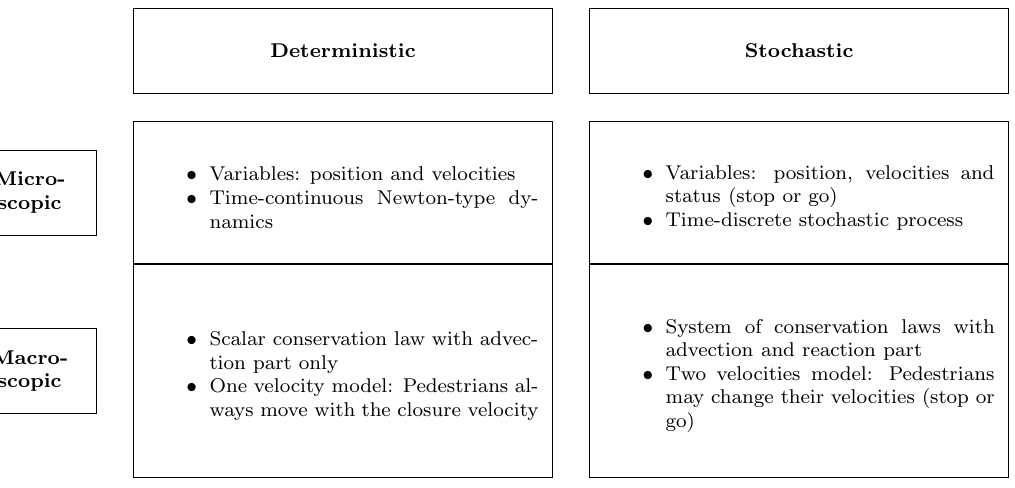
Figure 1: Overview of the deterministic and stochastic model